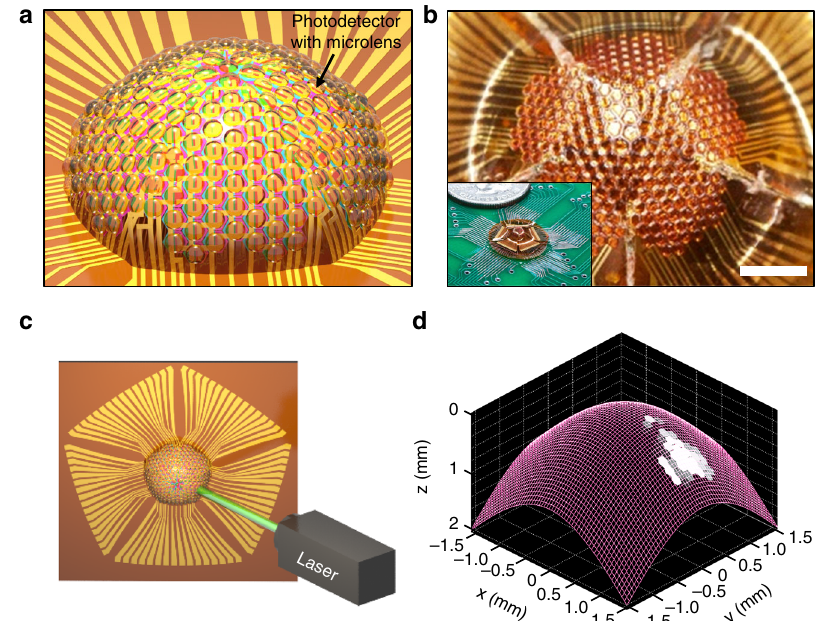
Fig. 4 A convex hemispherical electronic eye camera system using origami silicon optoelectronics. a Schematic illustration of the convex hemispherical electronic eye camera based on origami silicon optoelectronics. Fully formed photodiode array fabricated into a net of half truncated icosahedron was covered and folded onto a convex mold to create the hemispherical geometry. b A photograph of the convex hemispherical electronic eye camera based on origami silicon optoelectronics. Each photodiode is integrated with a polymer microlens to mimic the corneal lens in a compound eye. Inset image shows a photograph of the compound electronic eye system mounted on a printed circuit board. Scale bar, 1 mm. c Optics setup of the compound electronic eye system shown using a schematic illustration, where the point laser is illuminated from an incident angle of 36°. d Image of the laser point acquired from